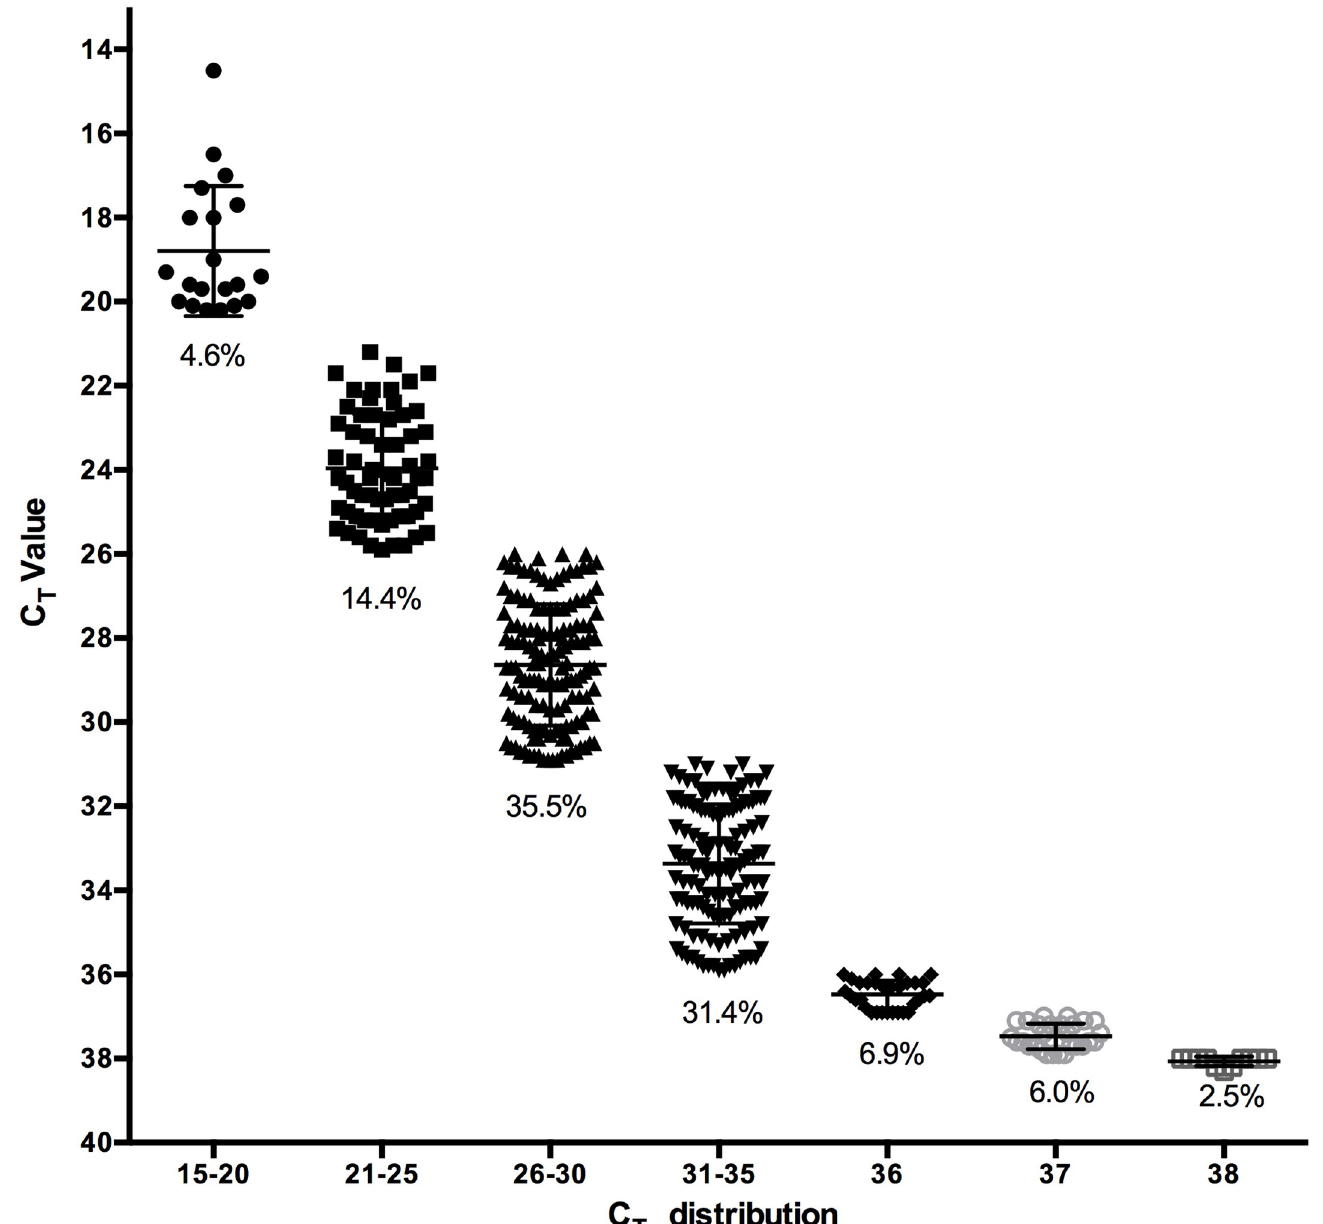
Fig 2. Distribution of C T values in positive samples. C T value of viral gene E from 436 positive samples are represented in intervals of five C T s, with exception of C T = 36, 37 and 38. The percentage from the total number of samples analyzed is indicated in the